Question: In one sentence, what is this figure communicating?
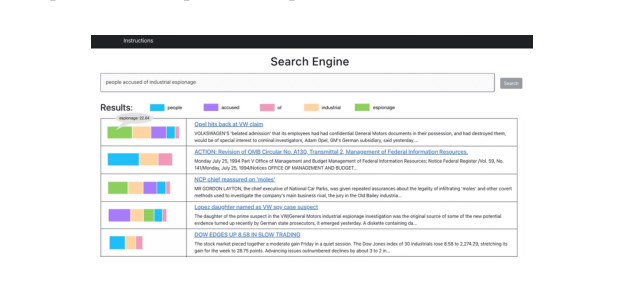
Answer: Search interface shown to Group A (modeled on the basis of the system presented by Ramos and Eickhoff [50]). On the left-hand side, the stacked bar graphs depict hypothetical scores of each keyword in the query for each respective search result. The larger the stacked bar graph, the more relevant that result is to the query.